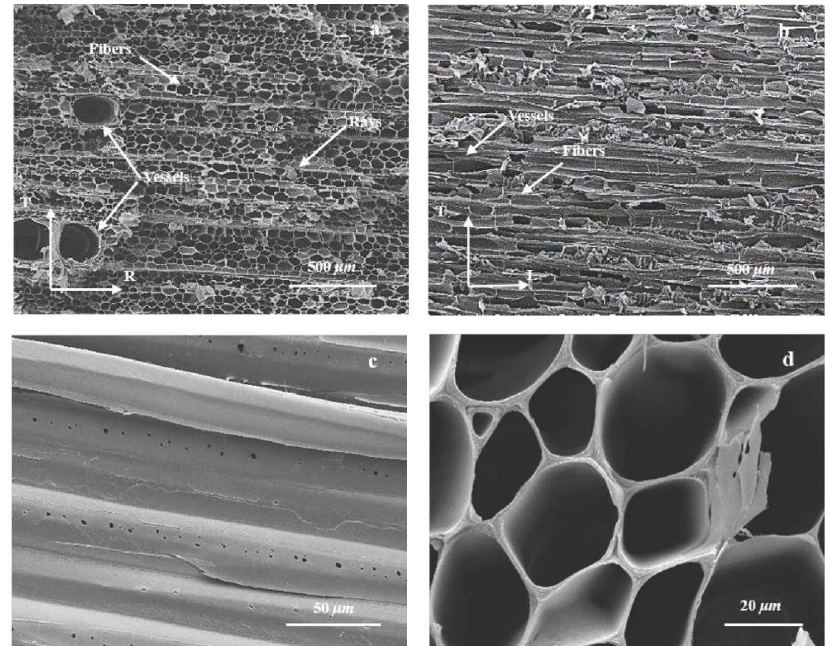
Figure 2. SEM micrographs of balsa wood ( a ) cross-section; ( b ) longitudinal view; ( c ) micropores on fibers; and ( d ) multilayer cell wall. L, R, and T refer to the longitudinal, radial, and tangential axes of symmetry.